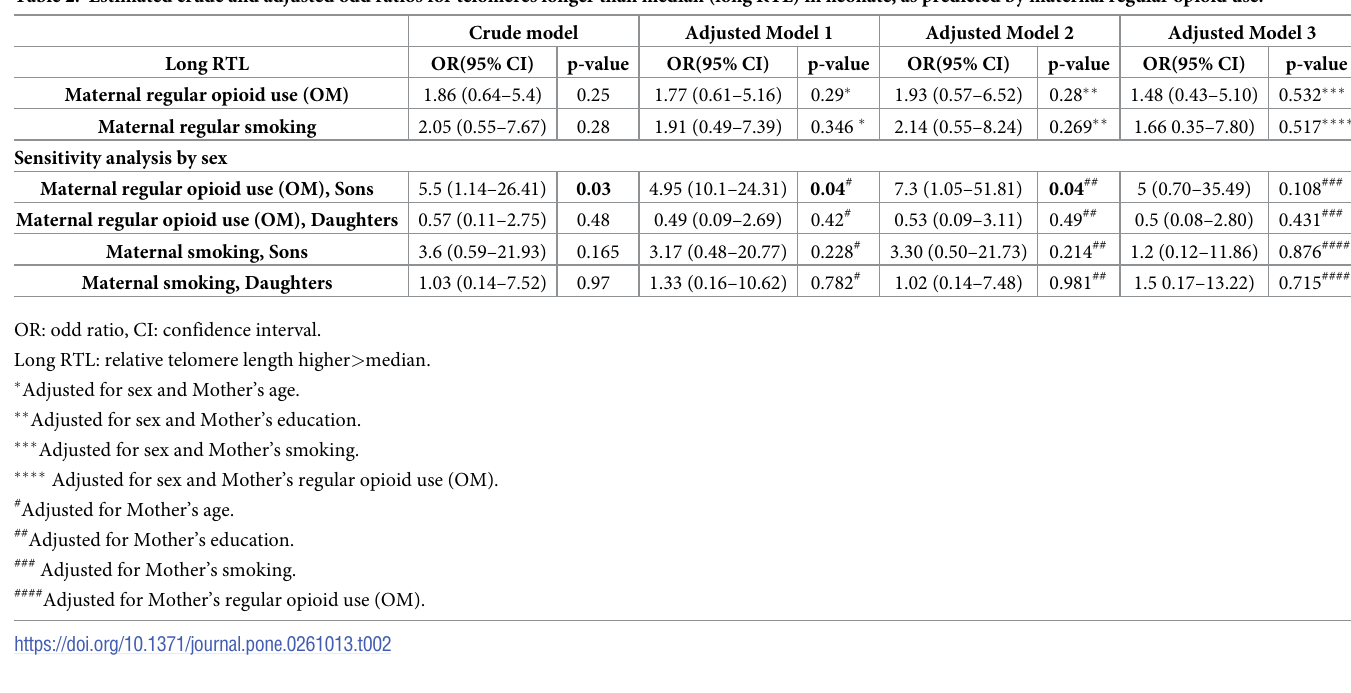
Table 2. Estimated crude and adjusted odd ratios for telomeres longer than median (long RTL) in neonate, as predicted by maternal regular opioid